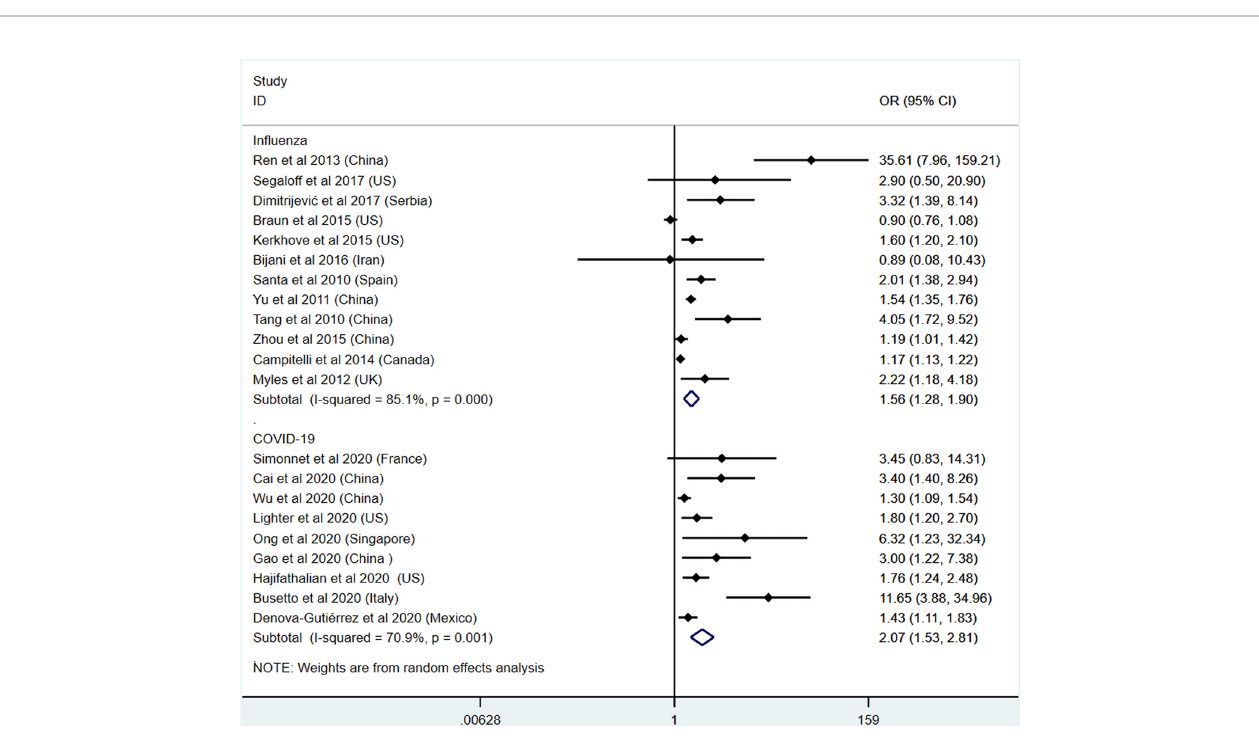
FIGURE 4 | Odds ratios for severe outcome or admission to ICU in patients with obesity and in fl uenza or COVID-19.